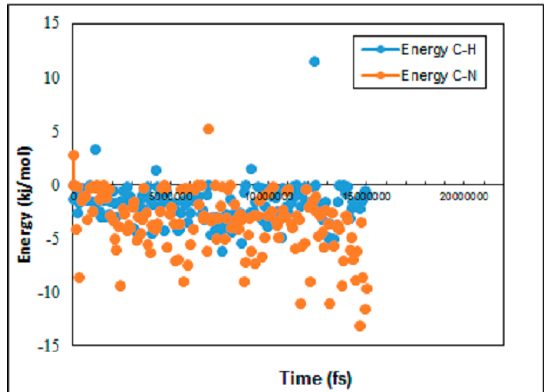
Figure 5. Energy profile for hydrogen and nitrogen molecules with the graphene layer versus time for pore density of 8% and pressure gradient 10 bar.